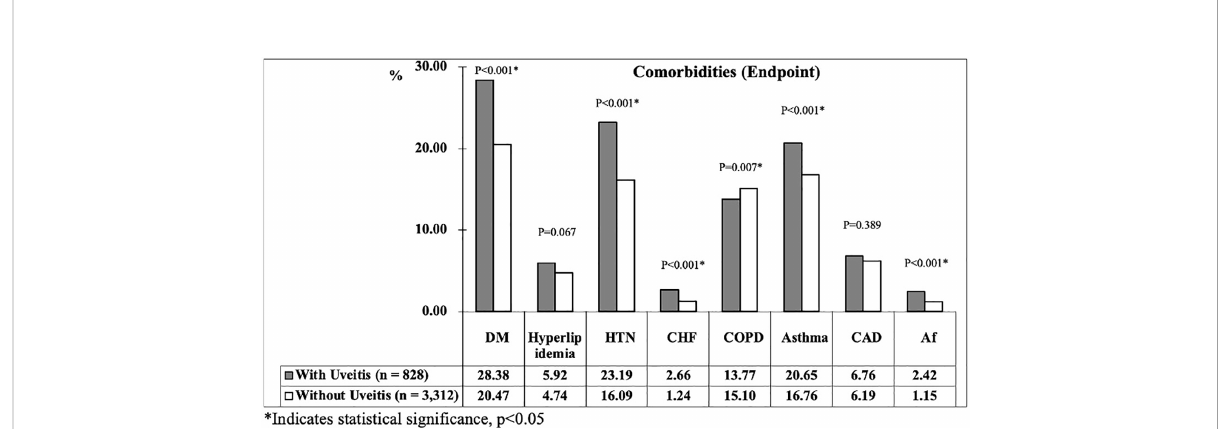
FIGURE 3 The prevalence of comorbidities between two groups at